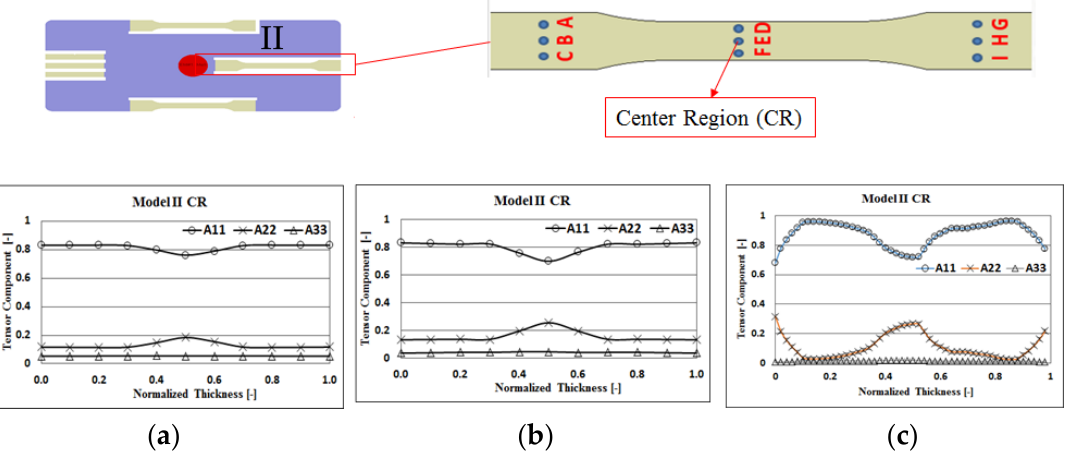
Figure 11. The comparison of the fiber orientation tensor components for Model II at Point E at CR: ( a ) simulation without flow–fiber coupling, ( b ) simulation with flow–fiber coupling, ( c ) experimental